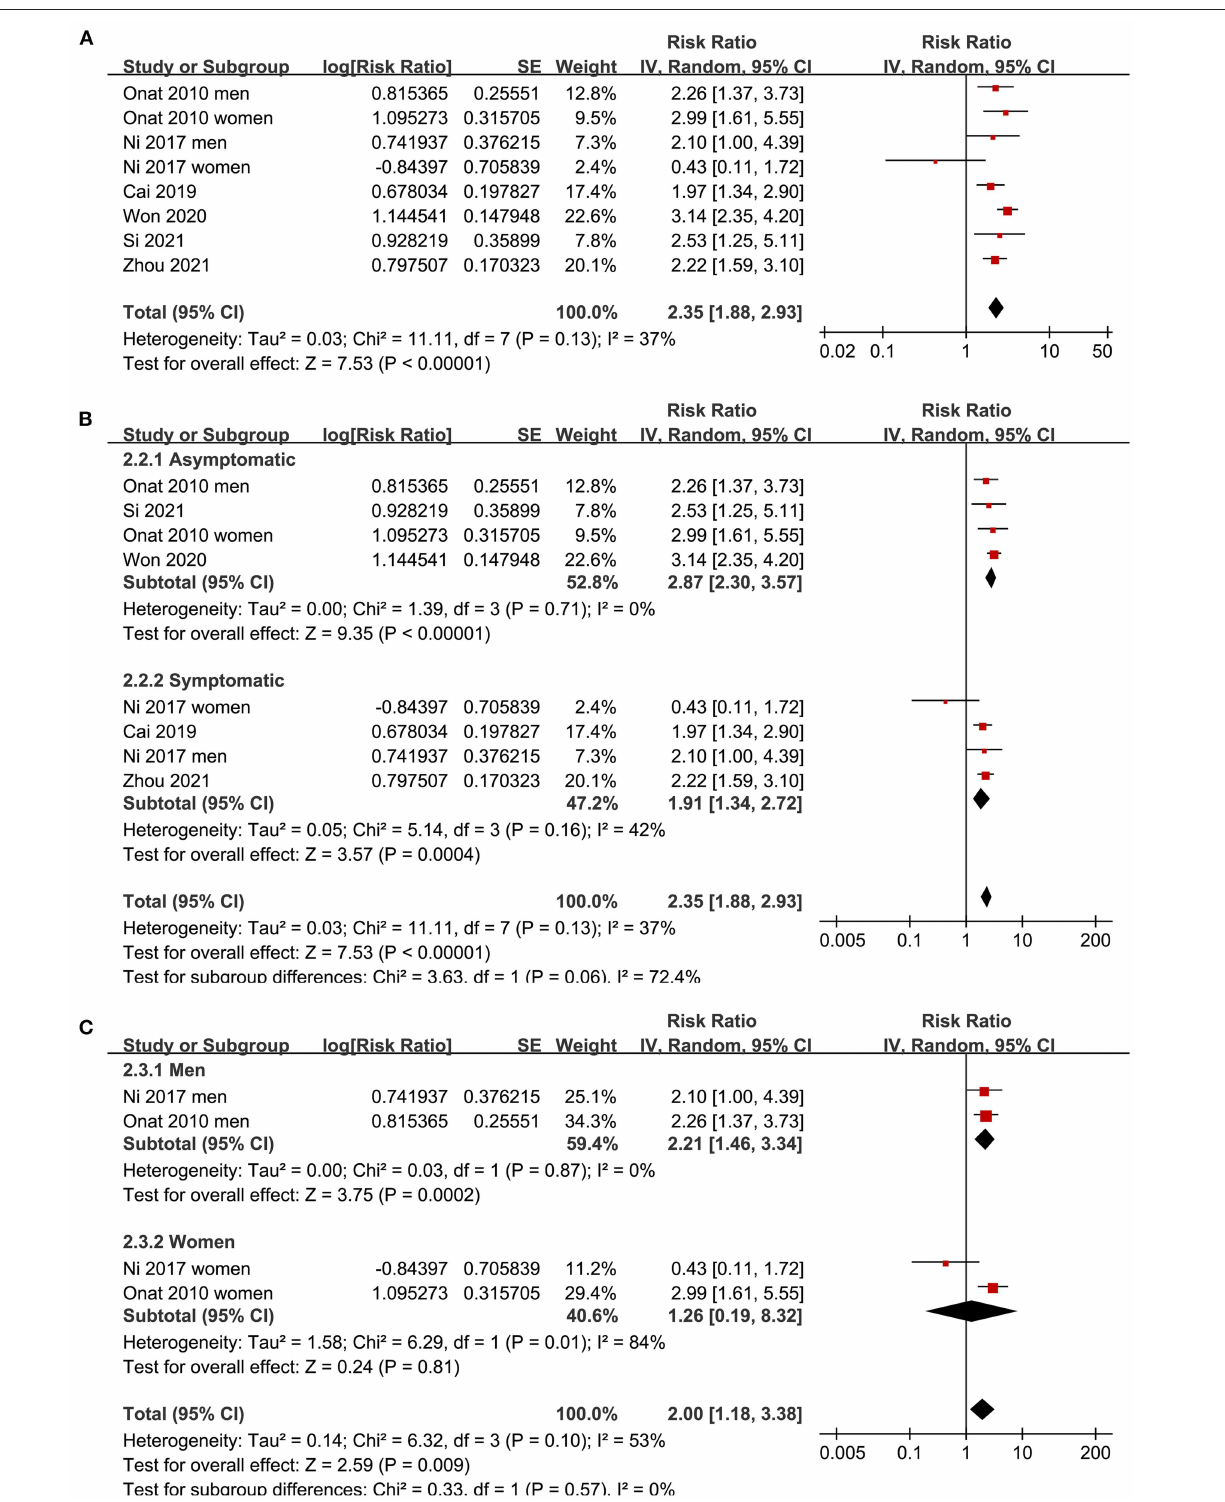
Frontiers in Cardiovascular Medicine |